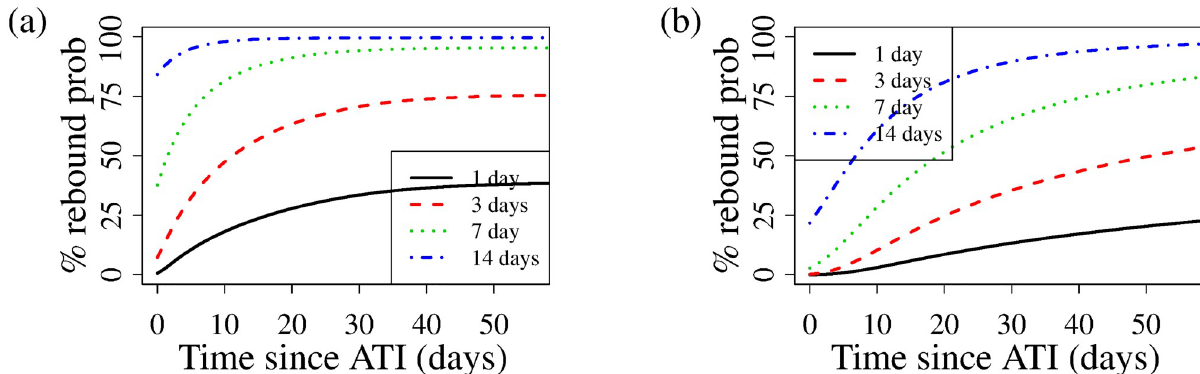
Fig 9. Model-recommended frequency of testing for ATI clinical trials, depending on study objectives, averaged over study population’s HIV CA-RNA levels. Probability of viral rebound given fixed testing frequencies of every 1, 3, 7, and 14 days, as a function of time since ATI for study participants whose pre-ATI ART regimen (a) excluded and (b) included